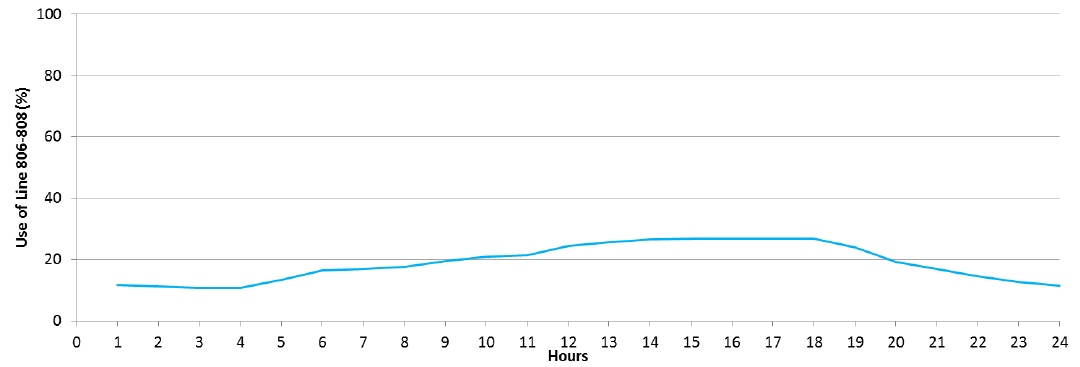
Figure 5 . Buses 806-808 Line Loading Capacity. Figure 5. Buses 806-808 Line Loading